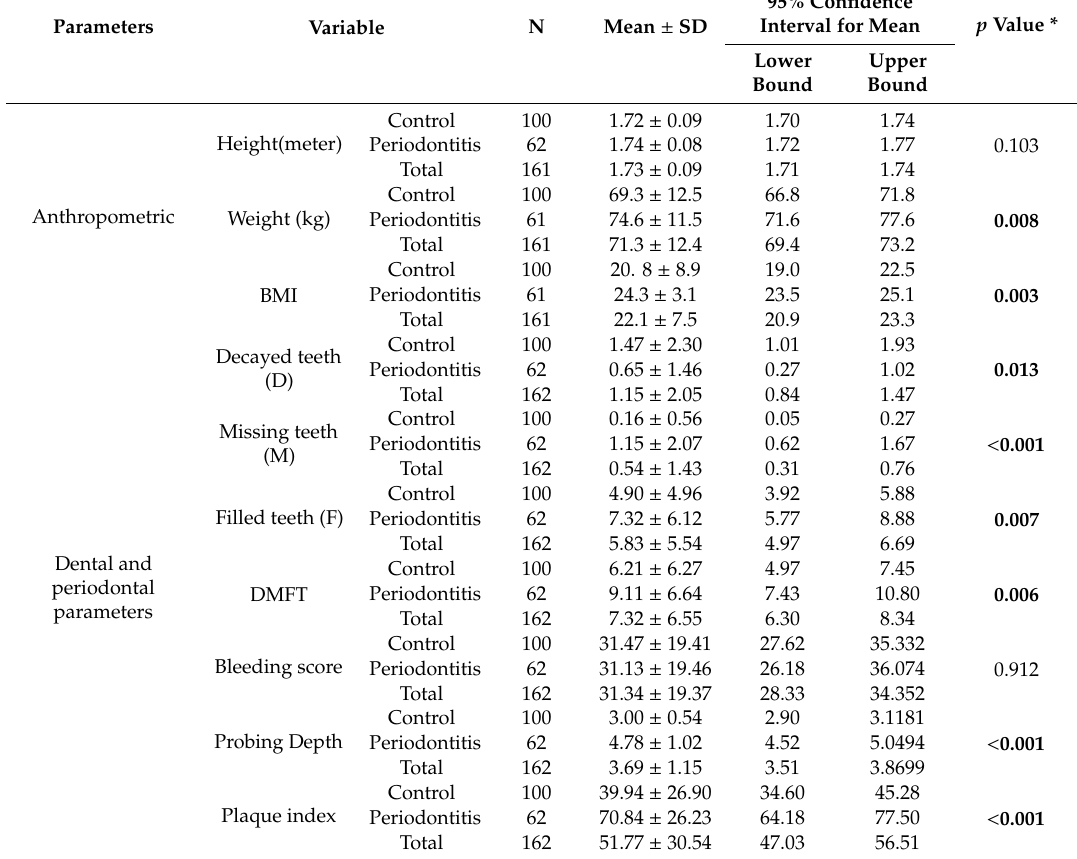
Table 2. Anthropometrics, dental and periodontal parameters of the study